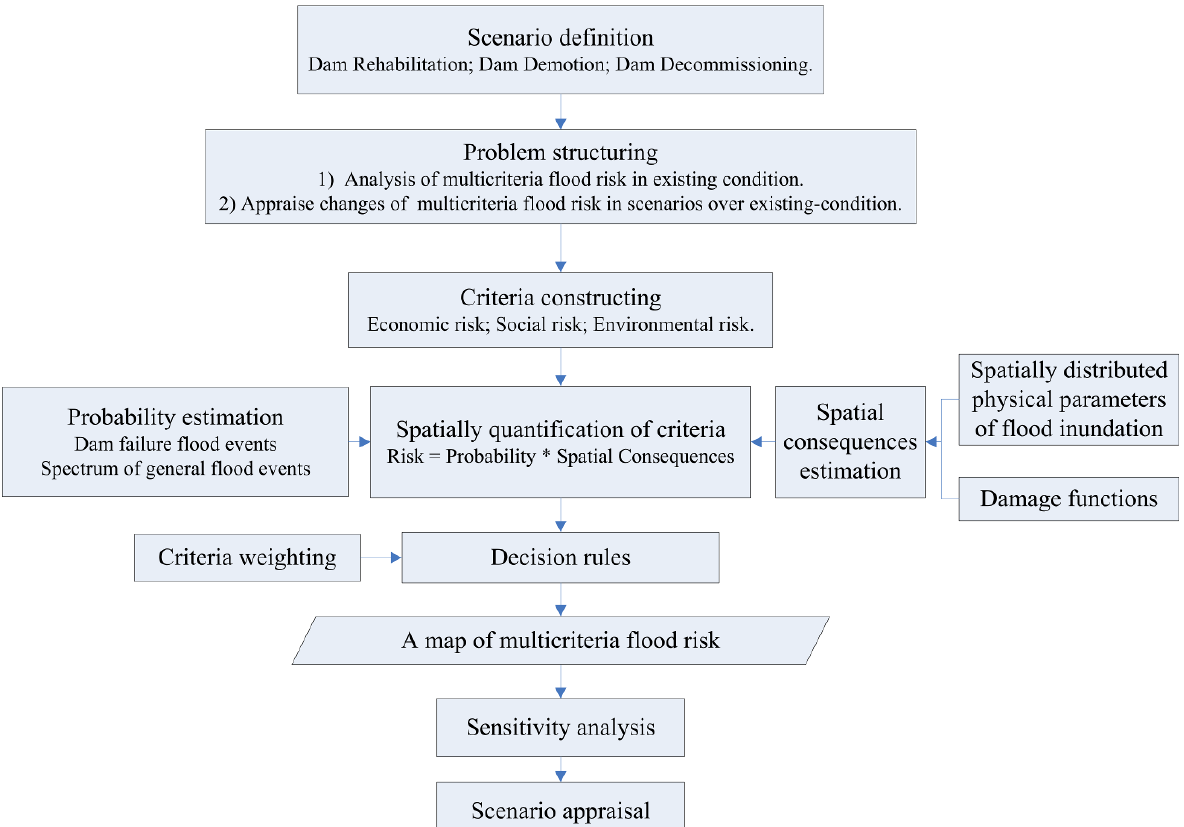
Figure 1. The general procedure of spatial multicriteria flood-risk analysis in the management of aging